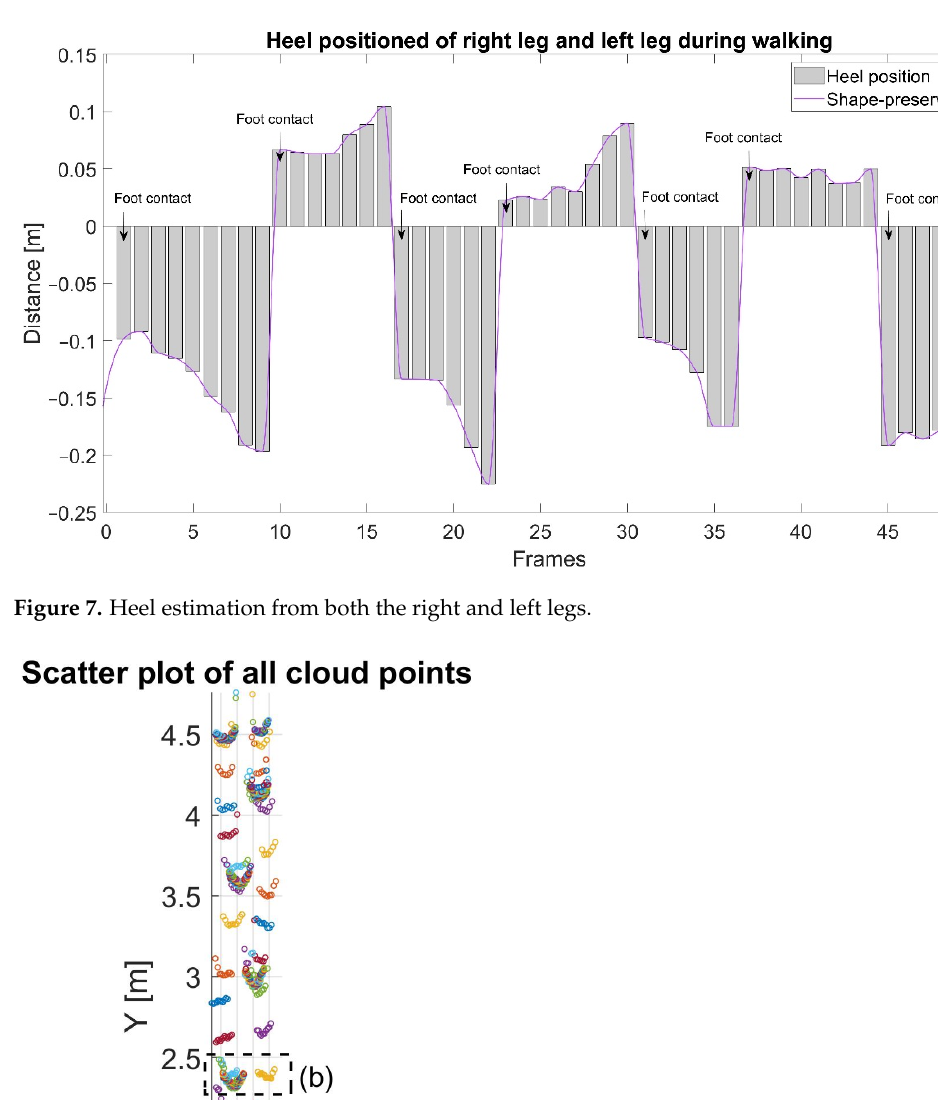
Figure 8. Scatter plot of all the cloud points during walking: ( a ) the identified single-support leg of the first step; ( b ) the identified single-support leg of the second step.